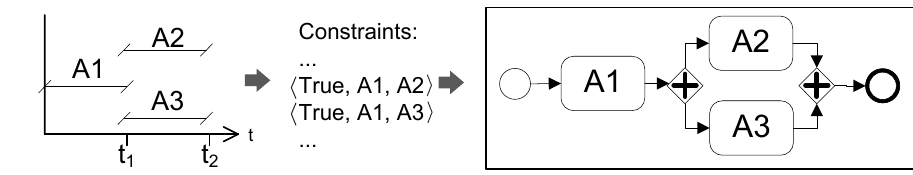
Figure 9. Parallel Relationship.